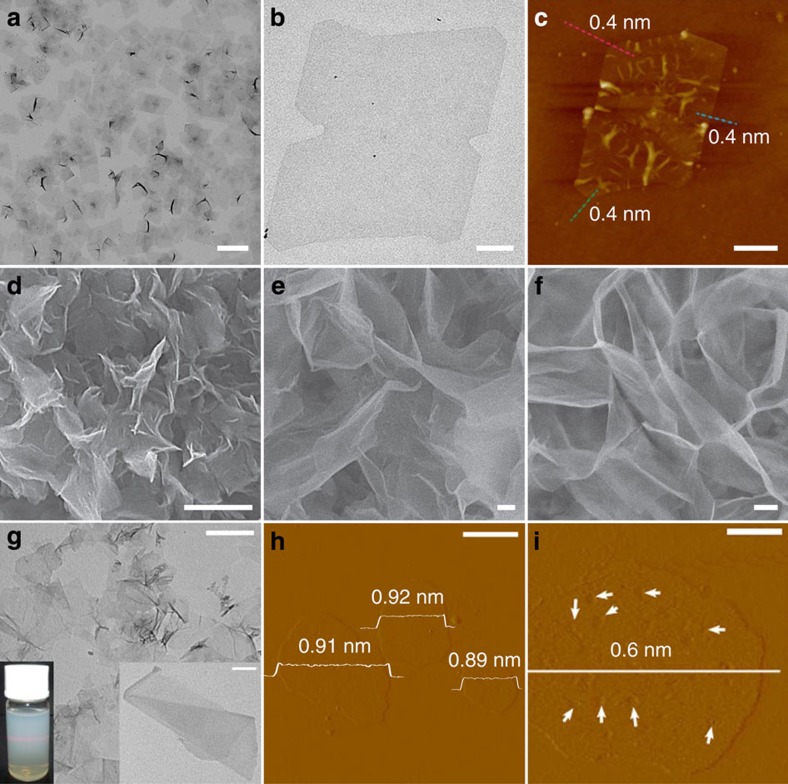
2D nanosheets synthesized using the hydro/solvothermal synthesis method.(a,b) TEM image of the PVP-capped Rh nanosheets, and (c) AFM image of a bare Rh nanosheet. Adapted from ref. 59. (d) SEM images of 2D nanosheets of TiO2, ZnO (e) and Co3O4 (f; scale bars, 200 nm). Adapted from ref. 60. (g) TEM image of ZnSe single layers (scale bar, 500 nm). Inset: the enlarged TEM image (scale bar, 100 nm) and Tyndall effect of ZnSe single layers. Adapted from ref. 61. (h) AFM image ZnSe single layers (scale bar, 500 nm). Adapted from ref. 61. (i) AFM image of ultrathin surface-pitted CeO2 sheets (scale bars, 100 nm). Adapted from ref. 62.